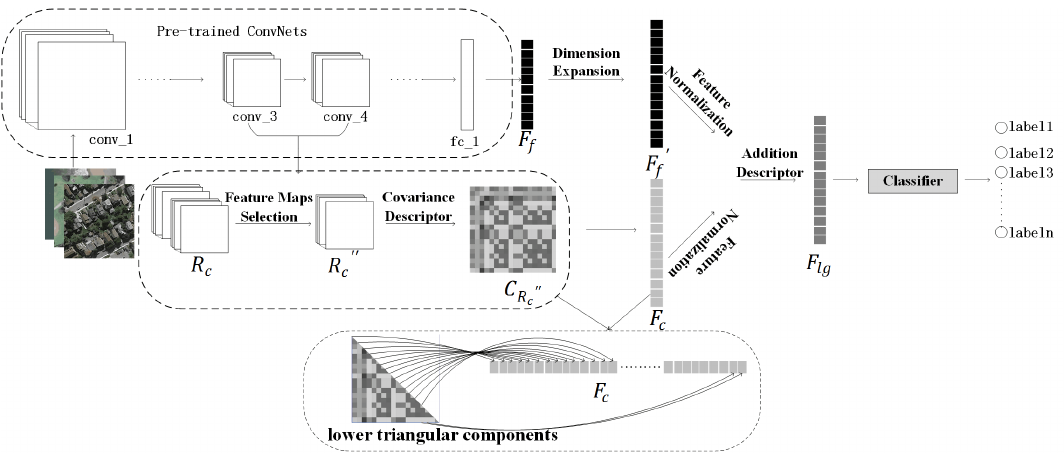
Figure 1. Overall architecture of the proposed method. Firstly, we extract multiple deep features from the pre-trained ConvNets. Secondly, process deep local features via feature maps selection algorithm and region descriptor. Finally, use an addition descriptor to fuse the two stream features and achieve